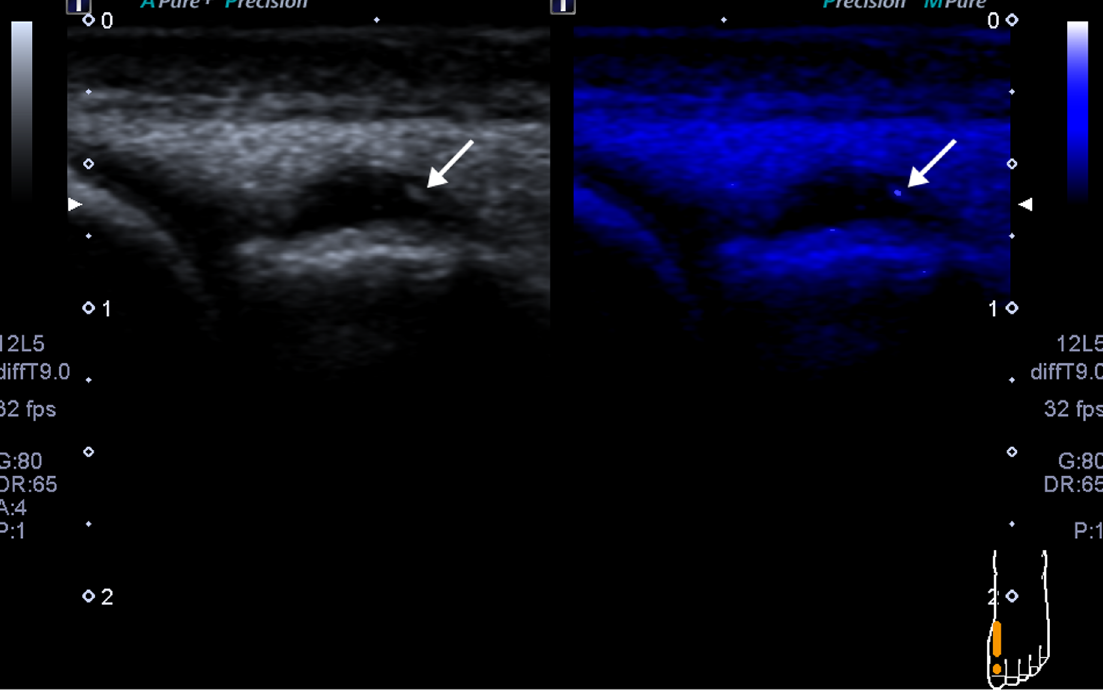
PLOS ONE | www.plosone.org 3 May 2014 | Volume 9 | Issue 5 |